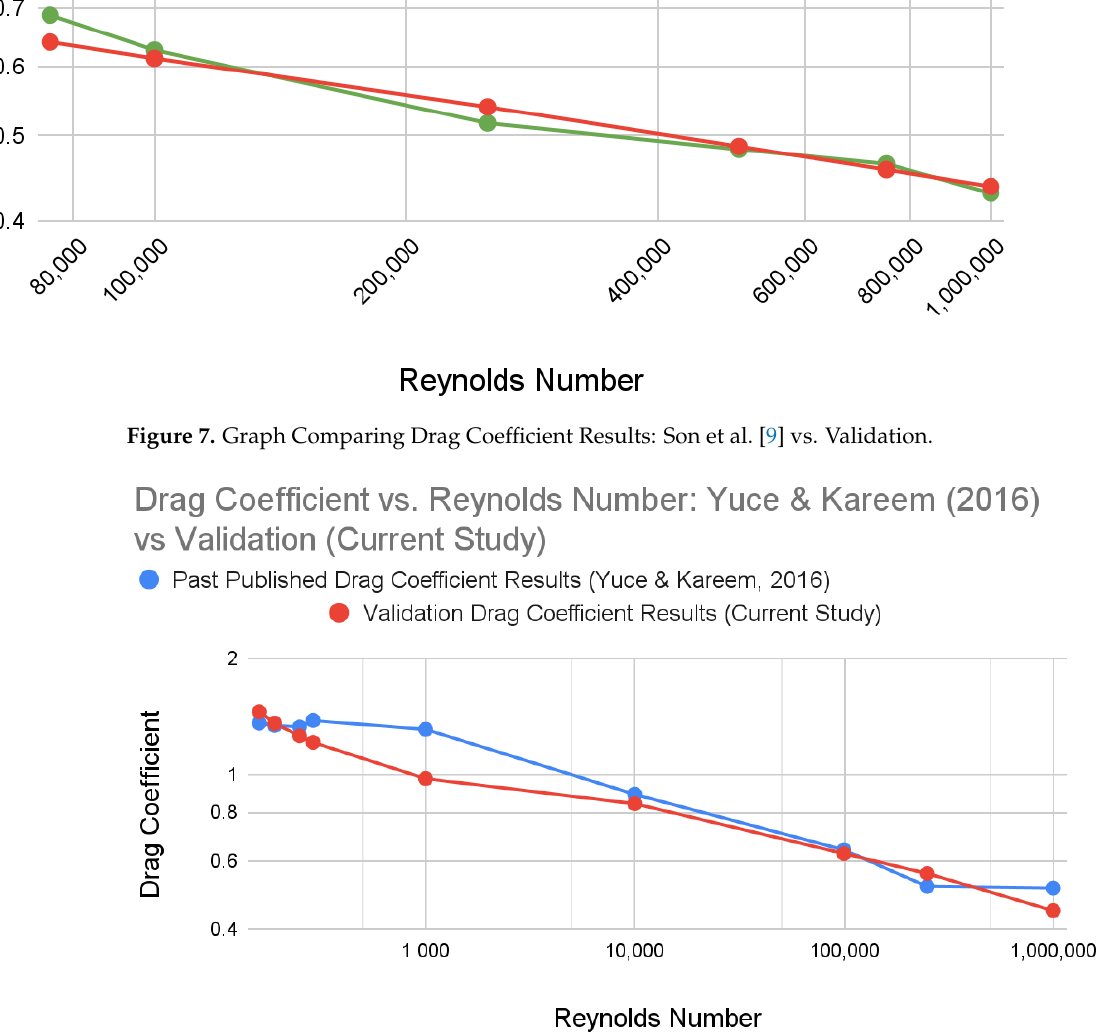
Figure 8. Graph Comparing Drag Coefficient Results: Yuce & Kareem [10] vs. Validation.